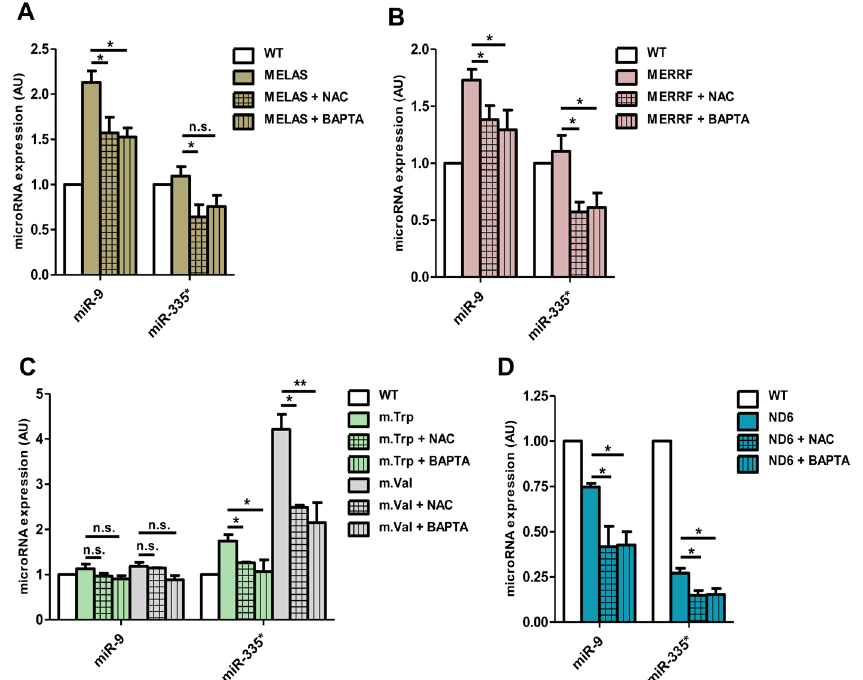
Figure 7. Elevated levels of ROS and intracellular Ca 2 + stimulate the expression of miR-9/9 * and miR-335/335 * in mutant cybrid cells. ( A–D ) qRT-PCR analysis of miR-9 and miR-335 * expression in MELAS ( A ), MERRF ( B ), m.Trp, m.Val ( C ) and m.ND6 ( D ) cybrid cells treated with either 1 mM NAC (antioxidant) for 48 h or 10 μ M BAPTA (Ca 2 + chelator) for 2 h. All data are the mean ± SEM of at least three different experiments. Differences from WT values were found to be statistically significant at * p < 0.05 and ** p <